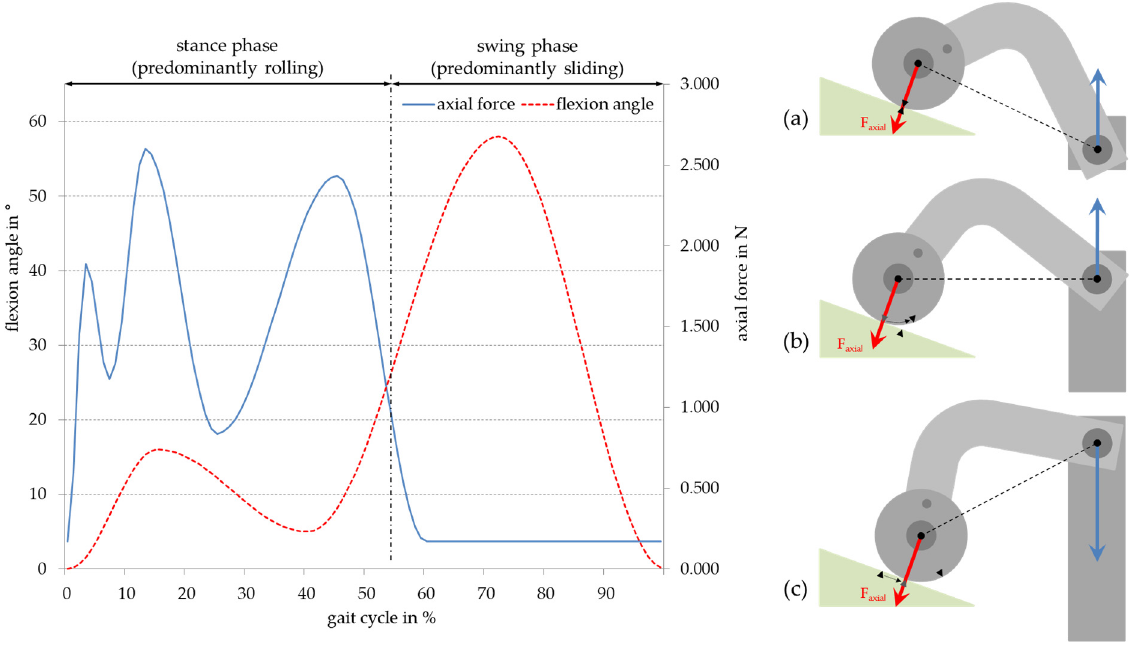
Figure 2. Motion sequence of the rolling-sliding test bench with the corresponding force according to ISO 14243–1 [15]: ( a ) Starting position of the lifting cylinder and rolling of the cylinder during lifting; ( b ) end of rolling and start of sliding down the plane; and ( c ) end of the motion sequence and start of the reverse cycle by sinking of the lifting cylinder.